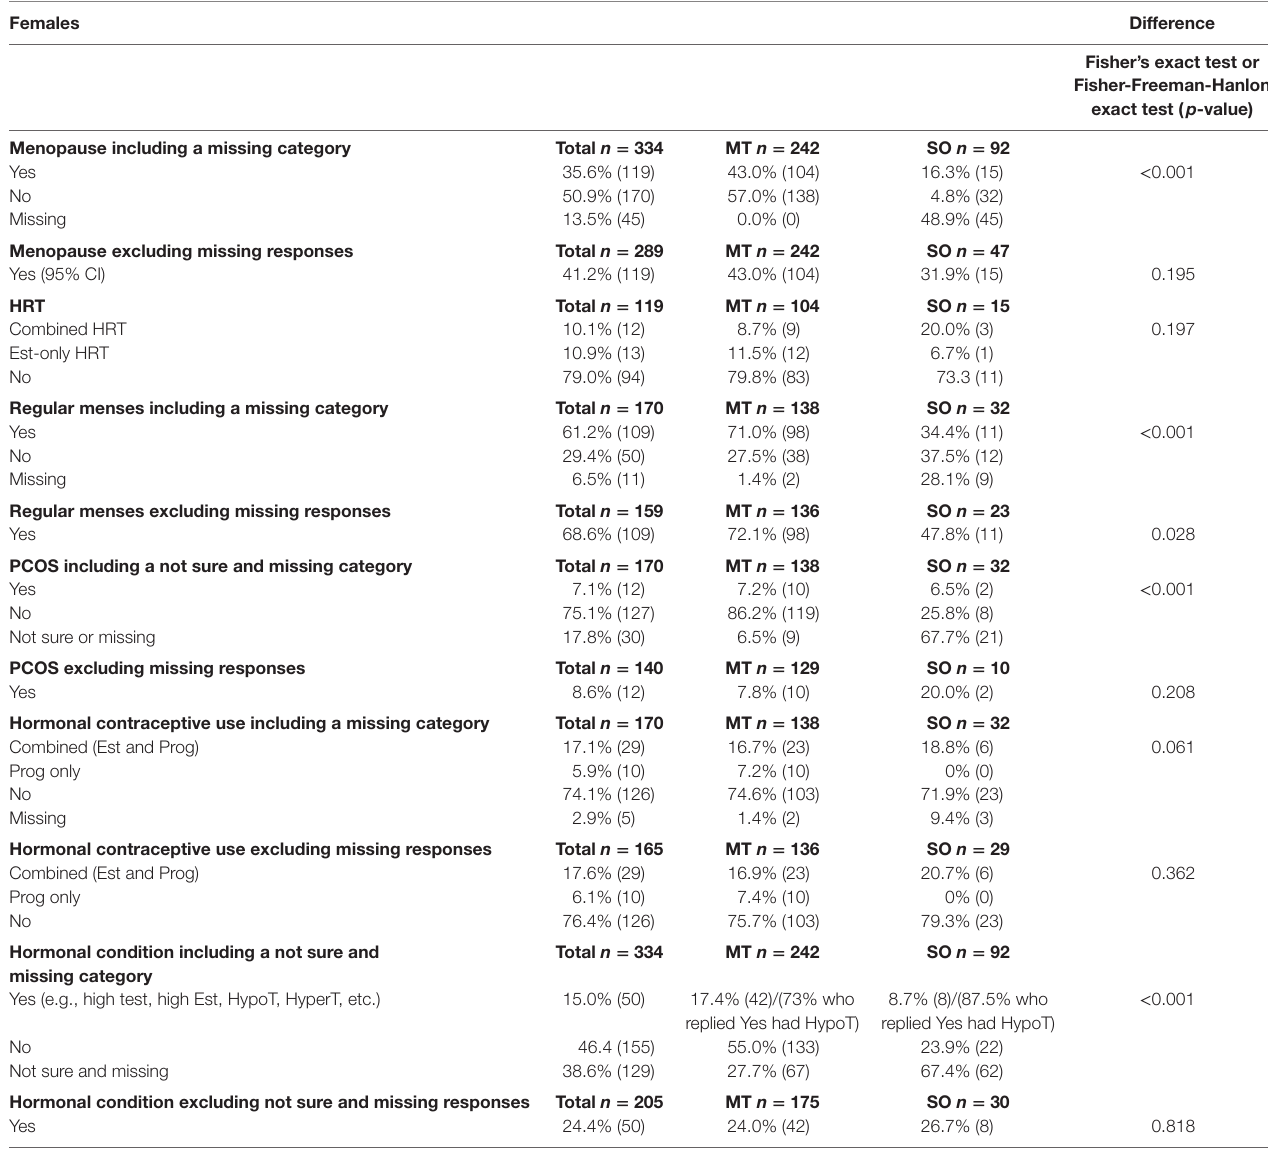
Table 3 | Hormonal-related data from female respondents in relation to MdDS onset (e.g., menopausal, use of HRT, use of contraceptive and hormonal imbalance conditions), presented as a percentage of the group and raw number. Females Difference